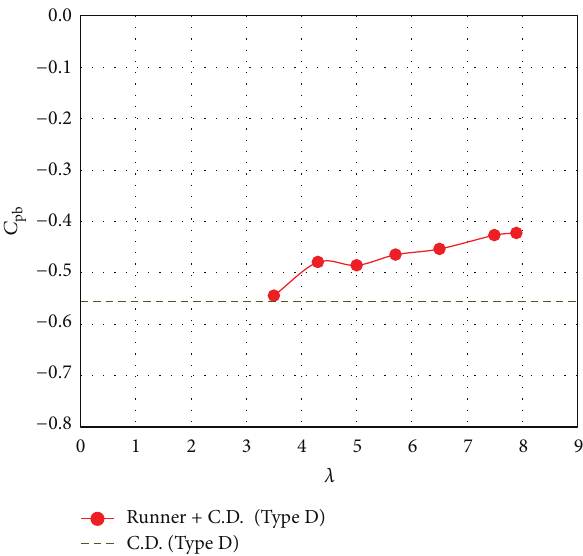
Figure 16: Correlation between the tip speed ratio and the diffuser pressure recovery coefficient.